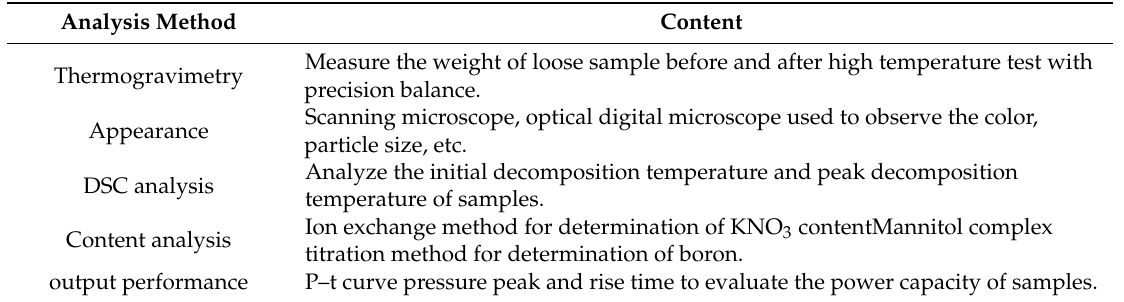
Table 2. Analysis methods for BPN thermal analysis and high temperature stability analysis.